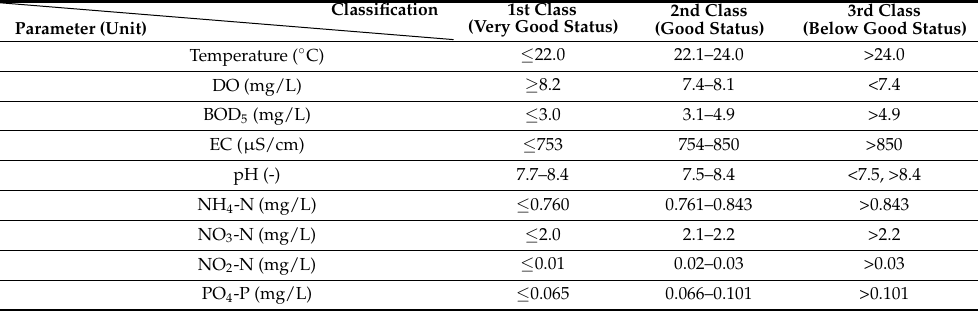
Table 2. Classification of the state of physicochemical elements for the tested research points of the Odra River (Poland).